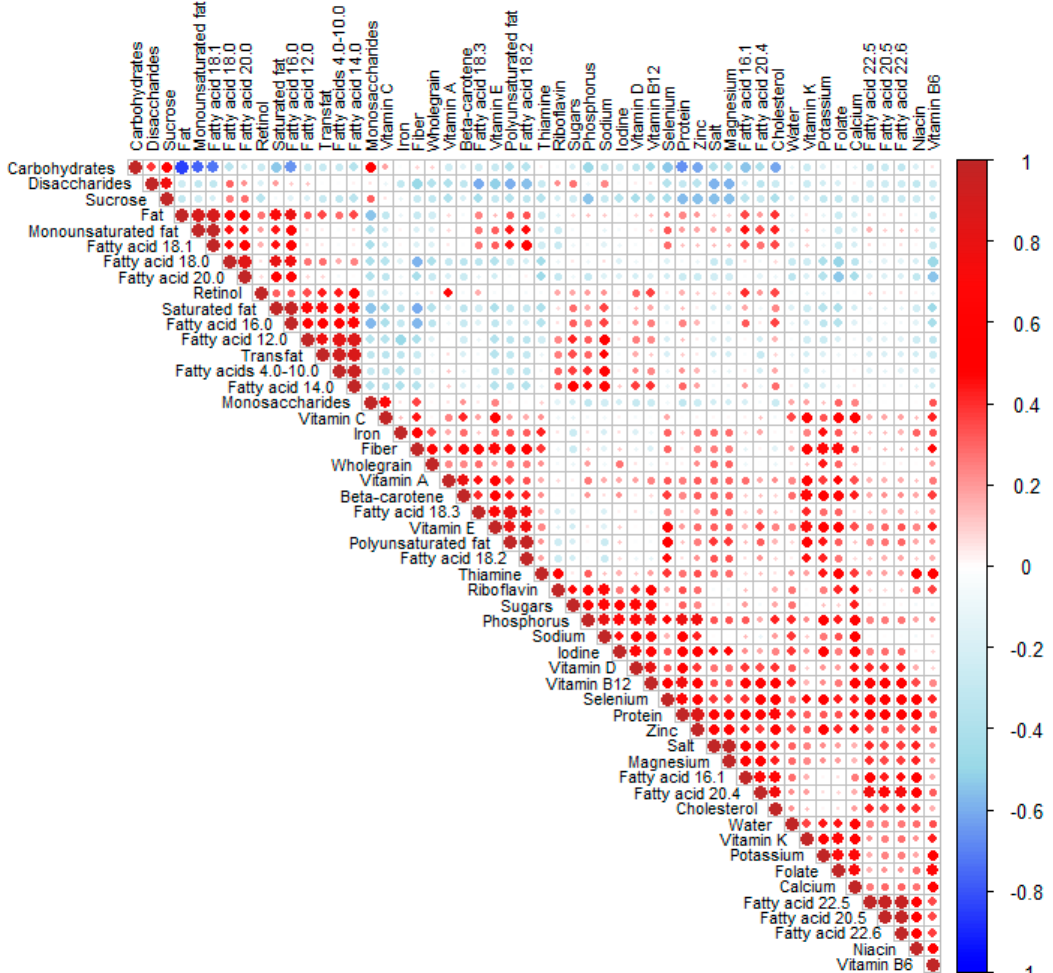
Figure 3. Correlation plot of energy-adjusted nutrient intake for all the subjects ( N = 567). The model groups highly correlated variables and places them next to one another so that the correlated variables form clusters. The magnitude of the correlation is denoted with a color, whereby red indicates a positive correlation and blue indicates a negative correlation. The size of the correlation is reflected in the darker color. The larger size of the symbol indicates a stronger correlation, with lighter colors and smaller size showing weaker correlations, according to the scale on the right-hand side.